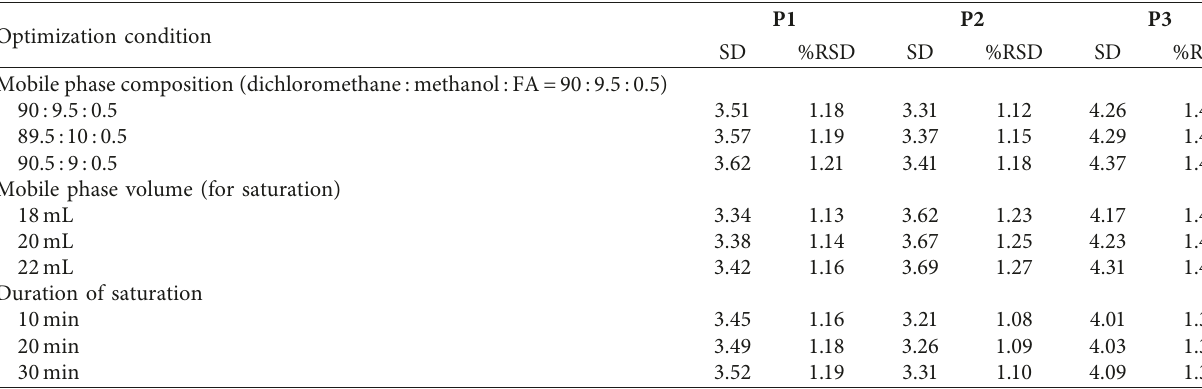
Table 8: Robustness of the proposed HPTLC method ( n � 6).